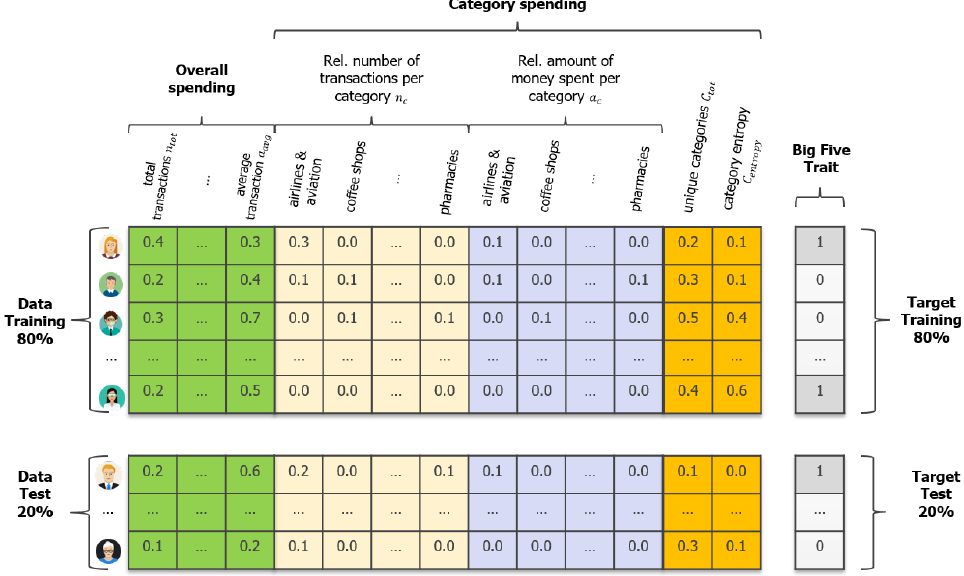
Figure 4. Pre-processed financial transactions data and binary target variable (Big Five